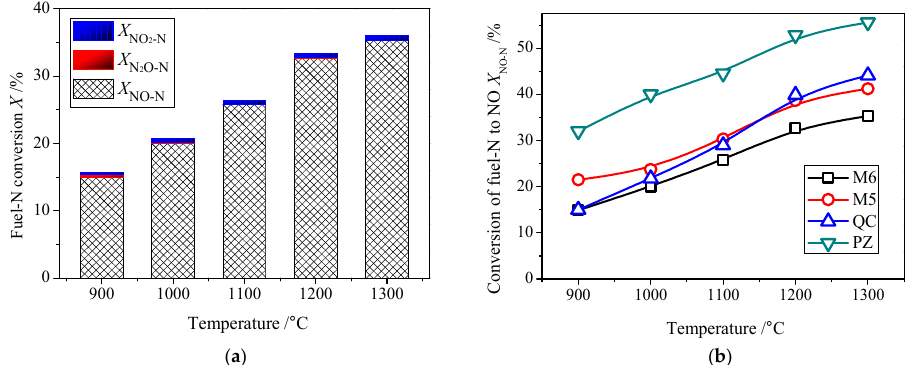
Figure 5. The effect of temperature on the release behaviors of nitrogen species under the 21% O 2 /79% CO 2 condition. ( a ) Nitrogen oxides from “M6”; ( b ) NO release behaviors. CO 2 condition. ( a ) Nitrogen oxides from “M6”; ( b ) NO release